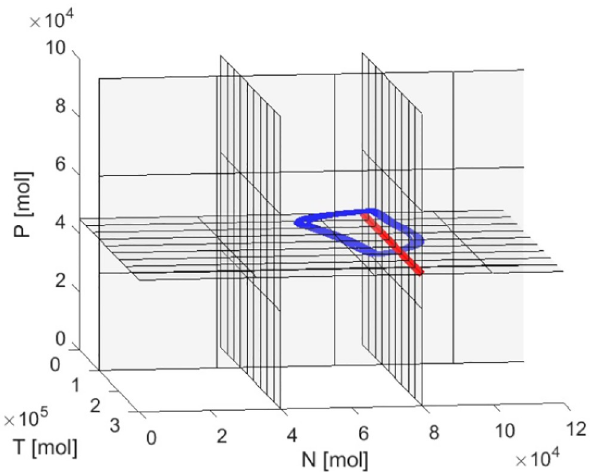
Fig 5. Localization of SSPs in the state space for different stress values. Red line indicates location of the SSPs. Blue line shows exemplary trajectory.